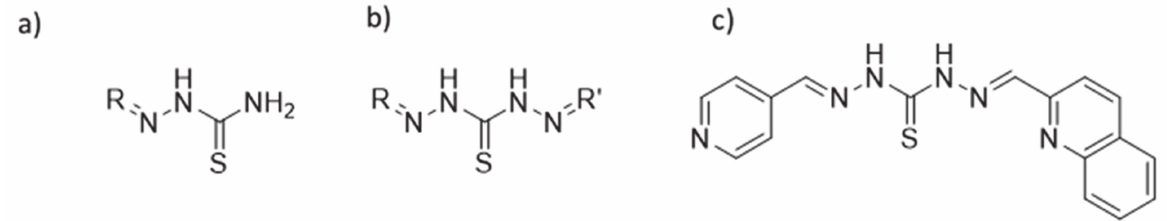
Figure 1. General structures of a thiosemicarbazone ( a ) and a thiocarbohydrazone ( b ) structure of the thiocarbohydrazone described in this paper ( c ). R and R (cid:48) can be both alkyl and aromatic